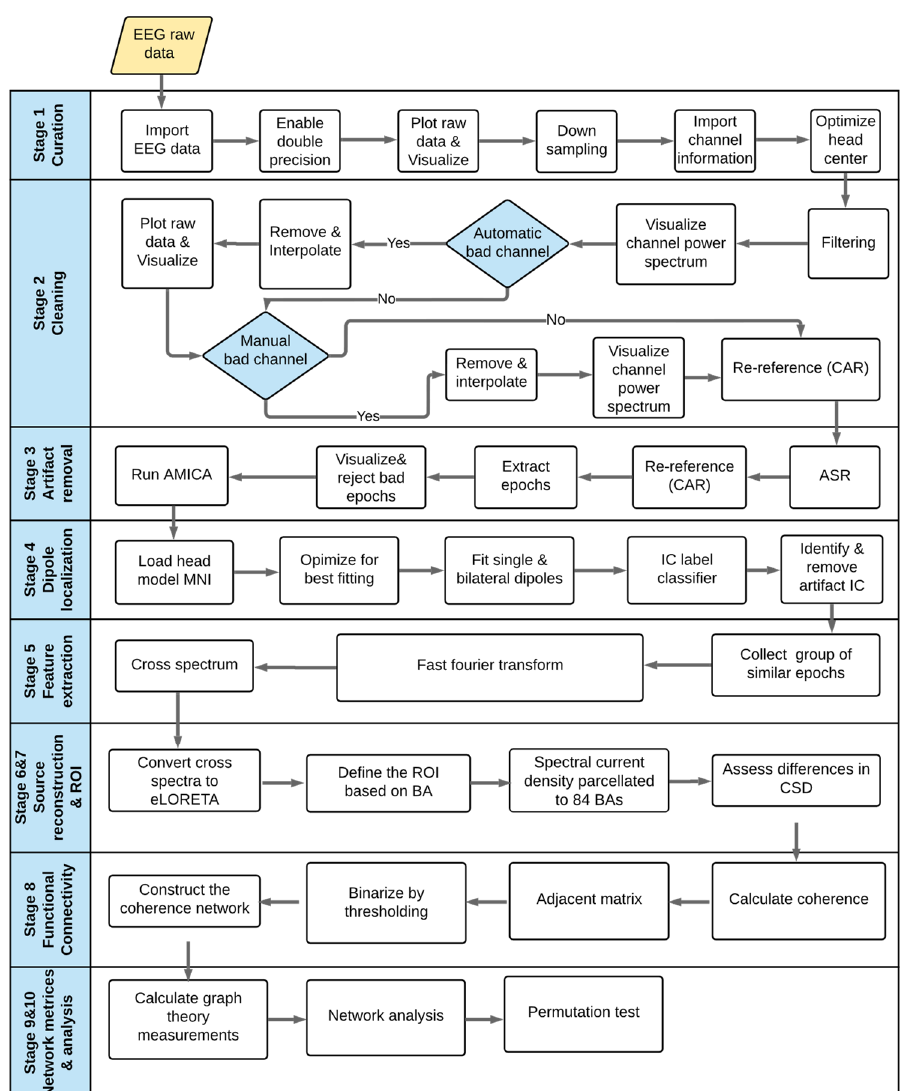
Figure 5. The data processing workflow. AMICA: adaptive mixture independent-component analysis, ASR: artifact substance reconstruction, BA: Brodmann area, CAR: common average referencing, CSD: current source density, eLORETA: exact low-resolution brain electromagnetic tomography, IC: independent component, MNI: Montreal Neurological Institute, and ROI: region of interest.